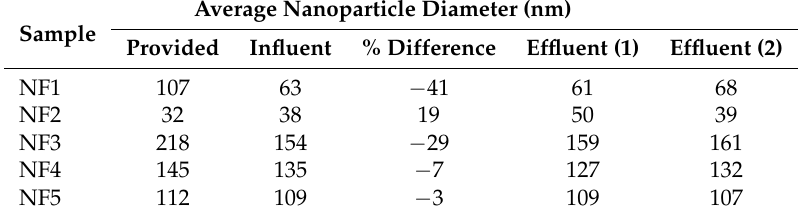
Table 8. The primary NP diameter in distilled water was provided by the manufacturer. The columns under influent, effluent (1) and effluent (2) report the average size of the NPs before injection, after secondary and tertiary nanofluid flooding,